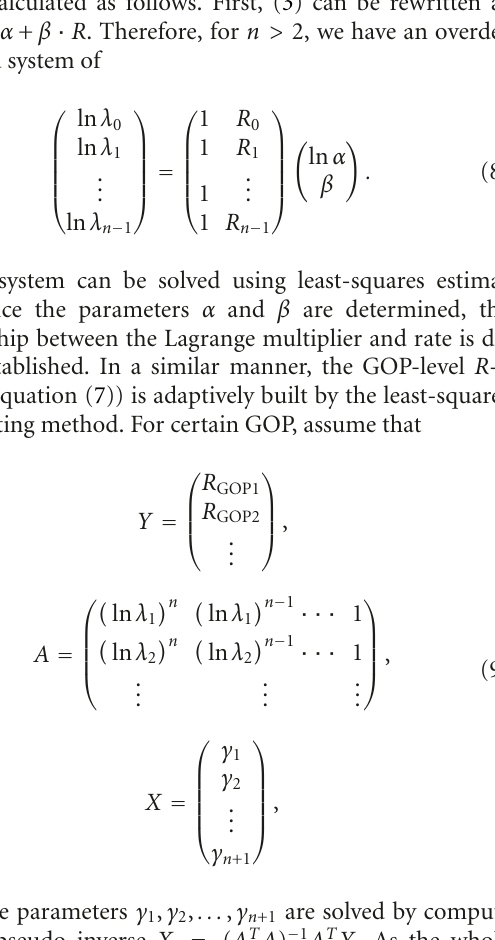
The coding block-level model (3) is used as an adaptive model since the source-dependent parameters α and β are estimated based on the input data. Given n pairs of numer- ical data ( λ i , R i ), i = 0, ... , n − 1, the parameters α and